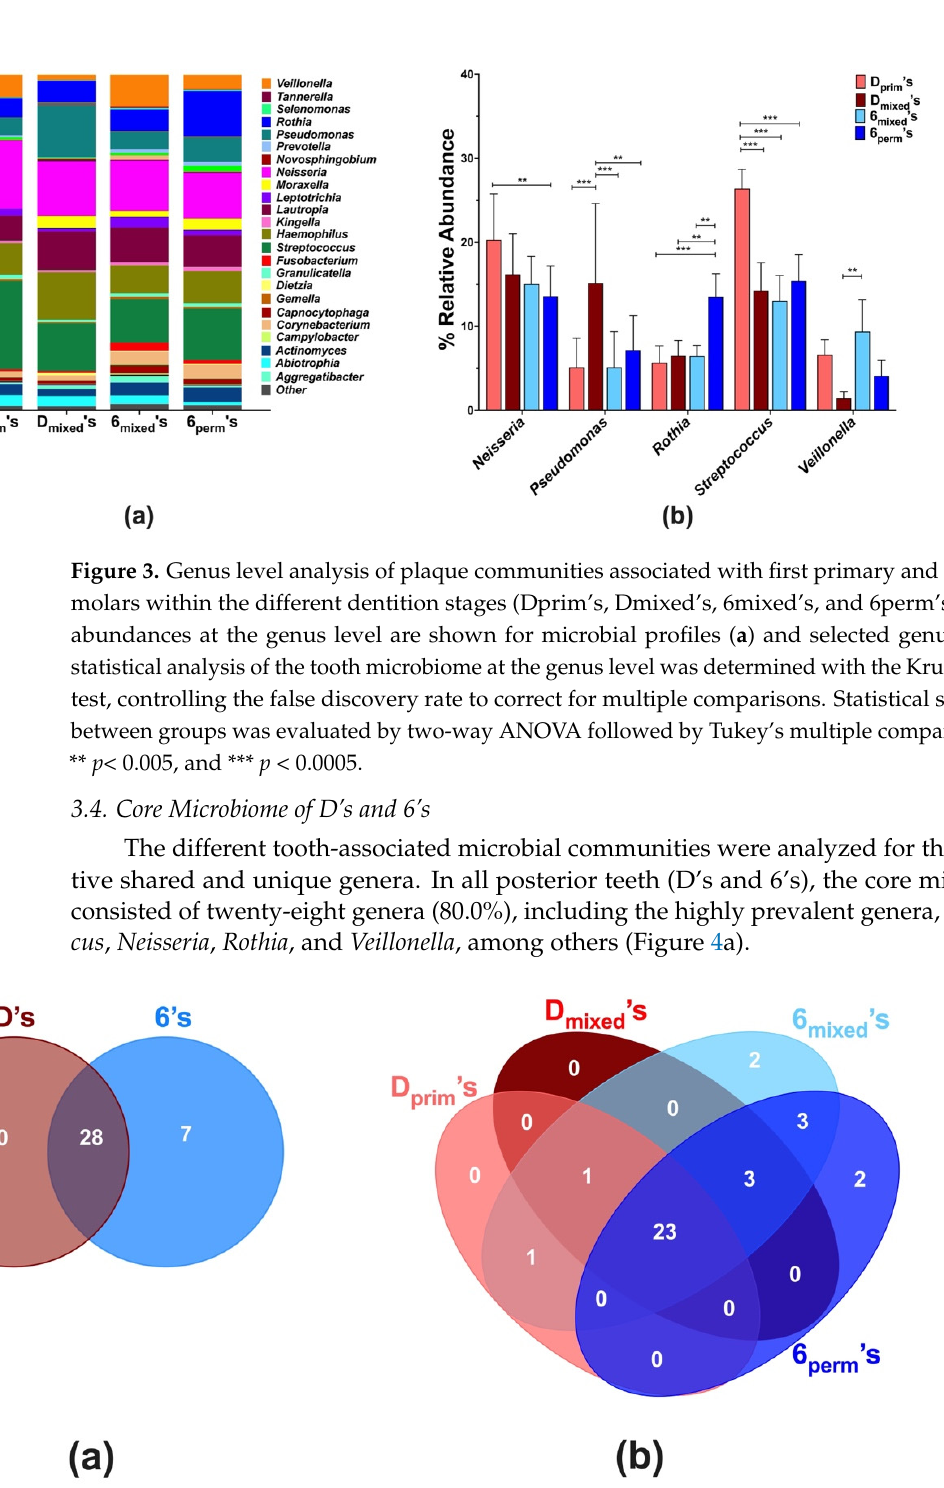
Figure 4. Core microbiome at the genus level of first primary and permanent molars (Dprim’s, Dmixed’s, 6mixed’s, and 6perm’s ). The analyses of the first primary and permanent molars teeth core microbiome are displayed as Venn diagrams, based on ( a ) type of tooth and ( b ) tooth type per dentition.